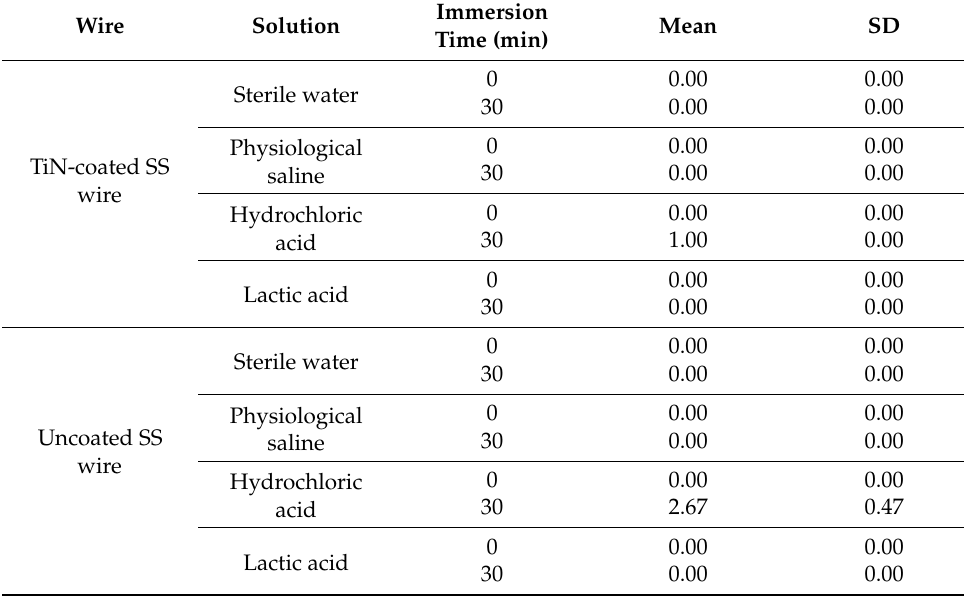
Figure 2. DMG test: ( a ) Positive reactions were scored; ( b ) SS wire immersed in HCl; ( c ) NiTi wire immersed in HCl. The statistical significance of differences was determined by the Tukey-Kramer HSD test. (* p < 0.05, ** p < 0.01). Table 3. DMG test results for SS